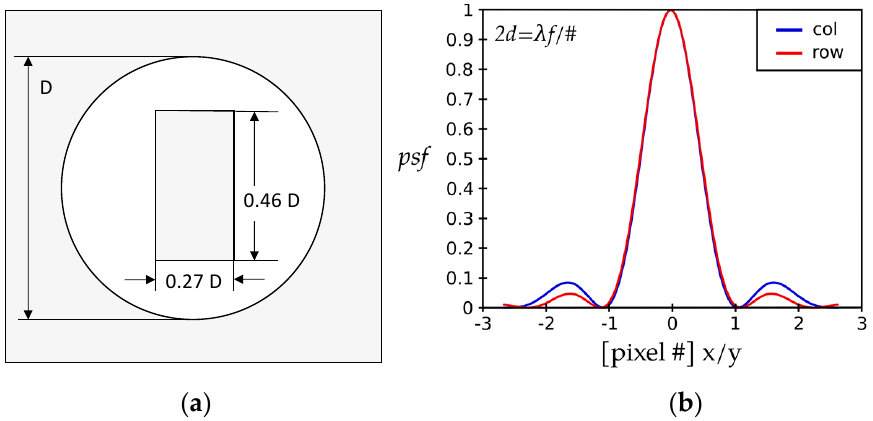
Figure 5. ( a ) Transmission profile of a circular pupil featuring a general rectangular central obscu- ration. Gray indicates zero-transmission. The size of the obscuration rectangle is 0.27 D × 0.46 D , where D is the diameter of the entrance pupil. ( b ) Point spread function, psf , of the circular pupil with the internal central obscuration shown in part ( a ). Different profiles are obtained along the x- and y-dimensions because the rectangular obscuration is asymmetrical.